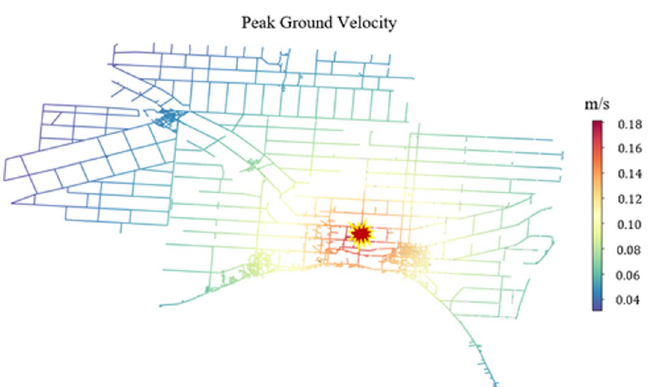
Figure 3. Spatial representation of computed PGV for a 5.5 M, and 15 km depth earthquake at Location